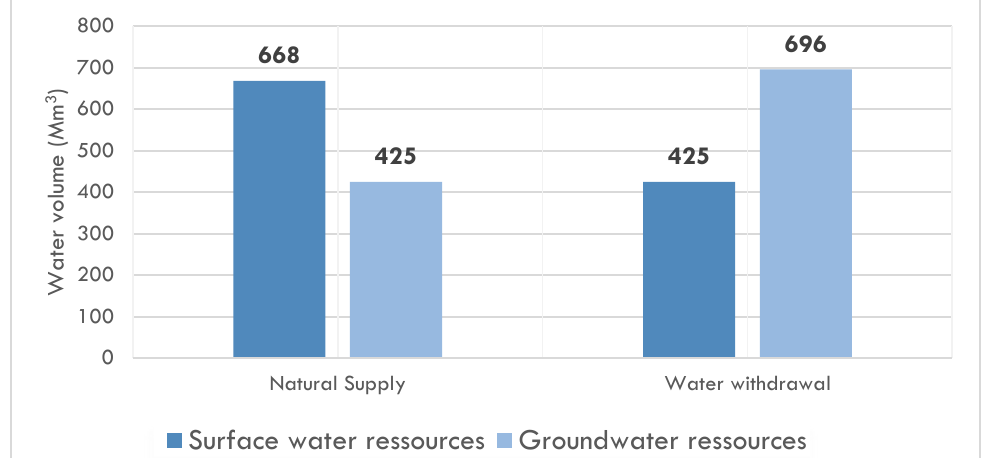
Figure 2. Water balance of Souss-Massa Basin.